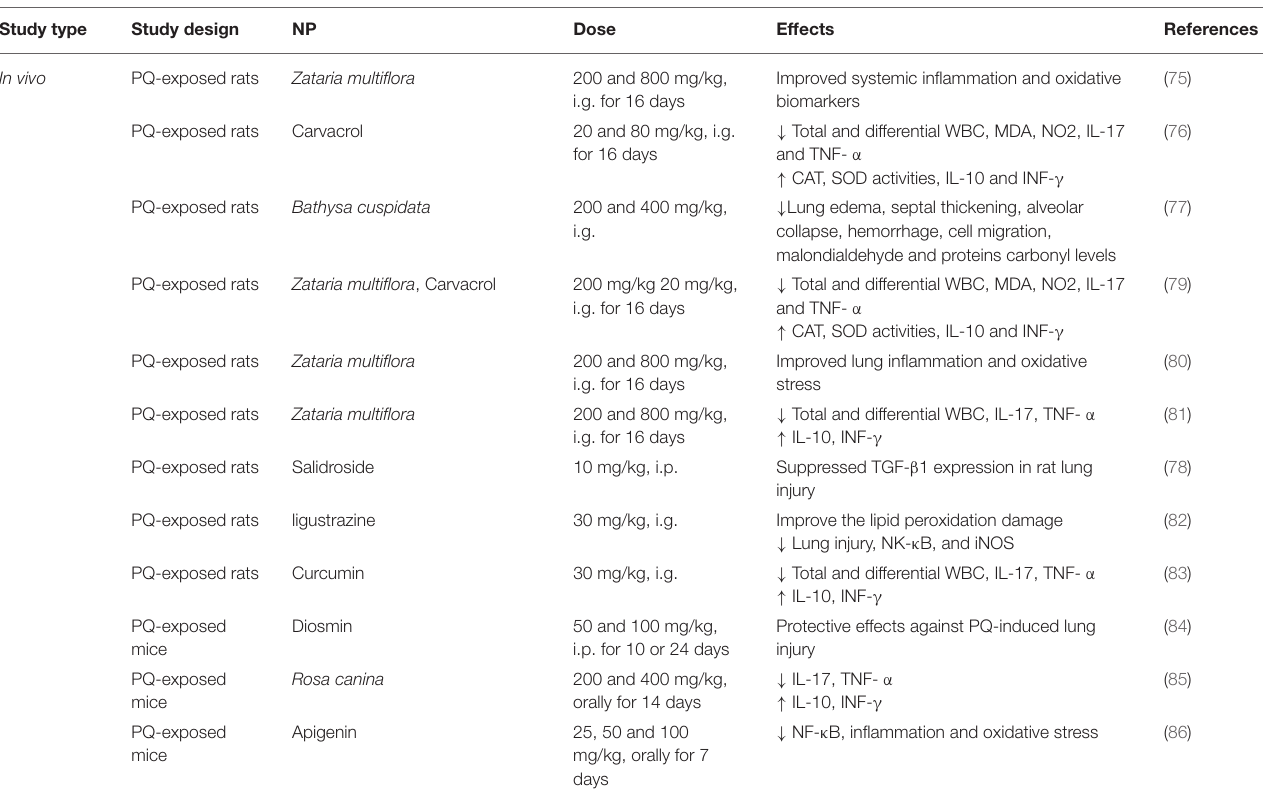
TABLE 5 | The possible therapeutic effects of NP in the PQ-induced lung